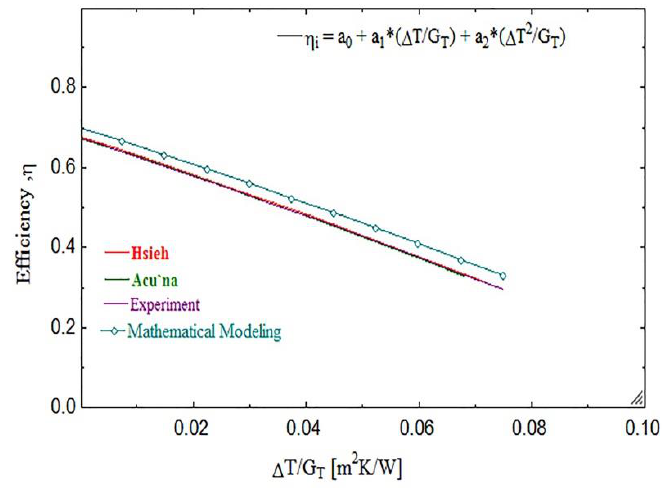
Figure 16. The efficiency of the collector has been compared with the maximum ambient temperature and with similar researches.